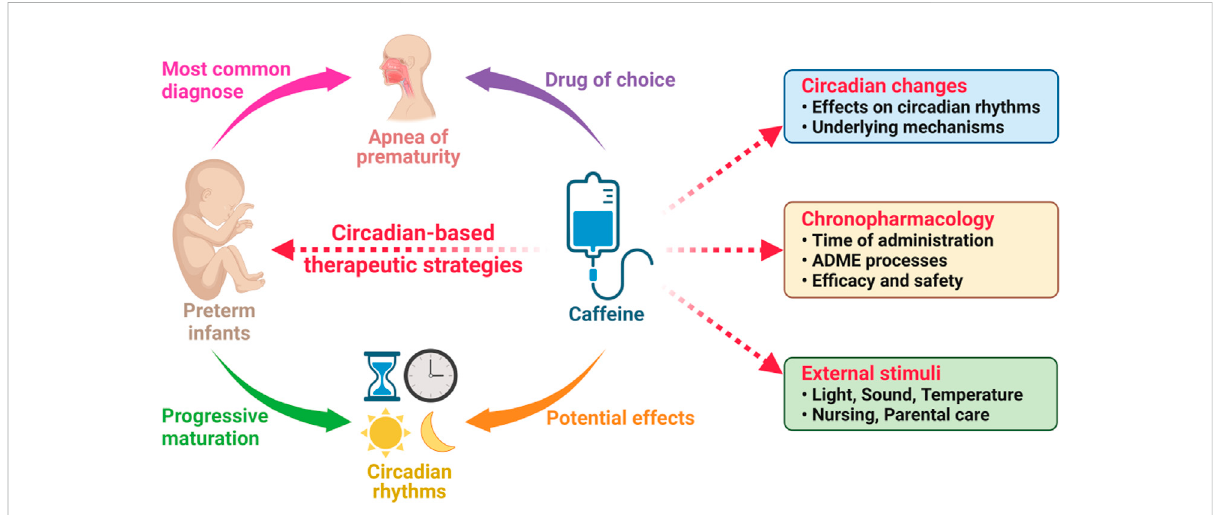
FIGURE 4 The circadian-based therapeutic strategies of caffeine in preterm infants with apnea of prematurity. ADME, absorption, distribution, metabolism, and